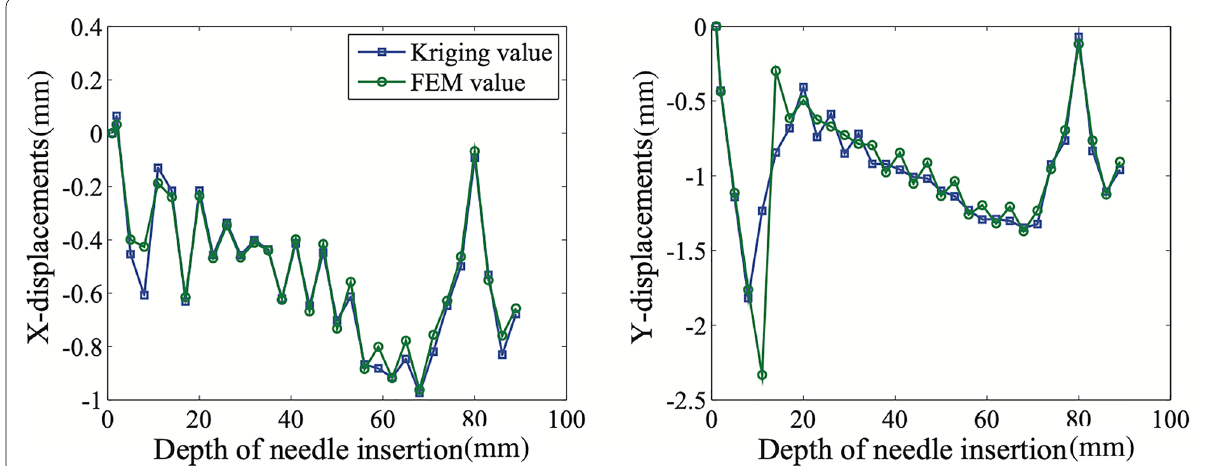
Figure 6 Kriging predictions for insertion depth-tissue displacement curve (N2)